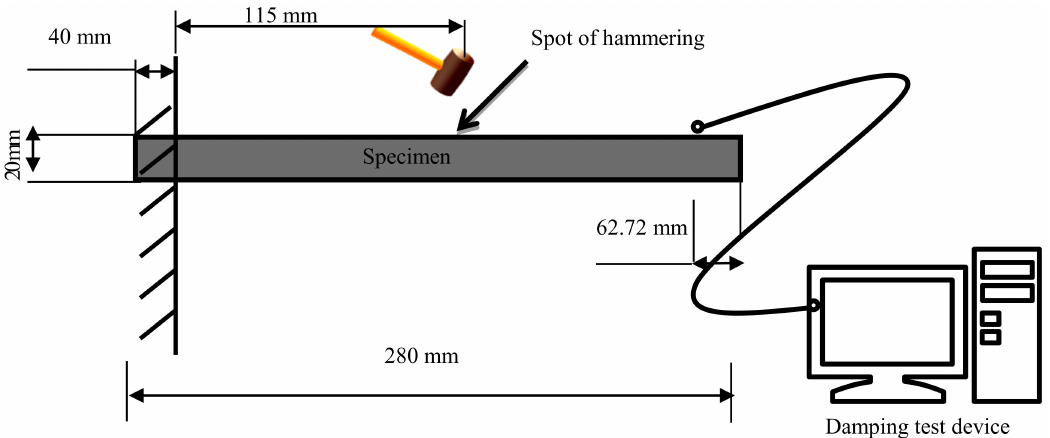
Figure 4. Schematic of the experimental setting and specimen dimension for the free vibration test.